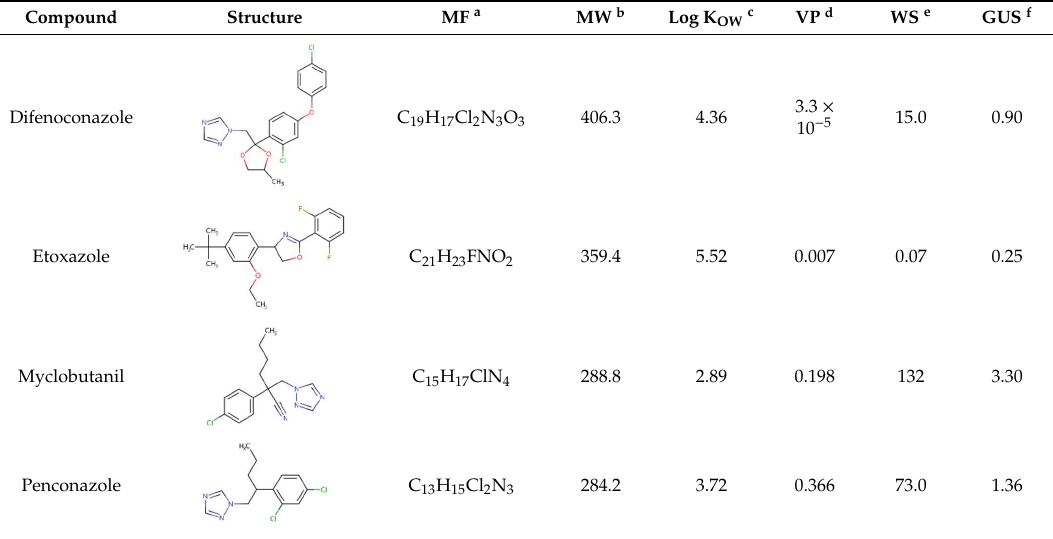
Table 3. Physical-chemical characteristics of the pesticides used in this study.